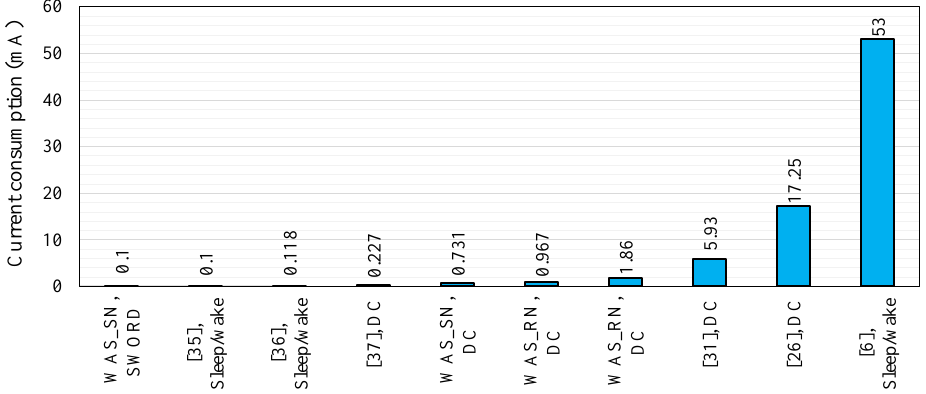
Figure 18. Current consumption of the proposed algorithms, together with the other energy efficient schemes used specifically in precision agriculture application.